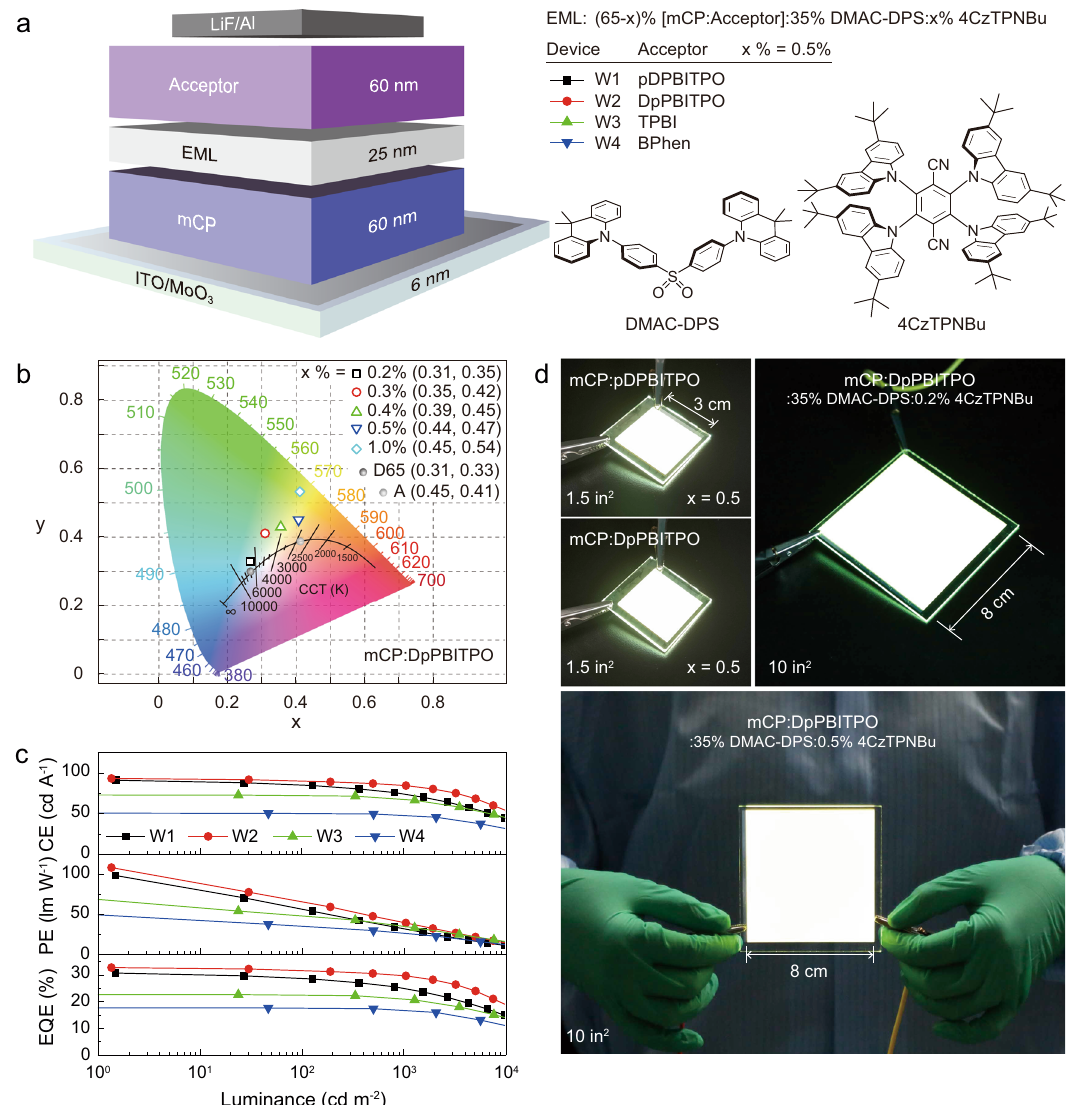
Fig. 4 Electroluminescence characterizations of single-emissive-layer TADF WOLEDs comprising ladder-like energy-relaying exciplexes. a An illustration showing device con fi guration, the emissive layer components of mCP:pDPBITPO- and mCP:DpPBITPO-hosted white TADF devices, and molecular structures of the doped dye emitters. b Commission International de I ’ Eclairage (CIE) coordinates of mCP:DpPBITPO-hosted TADF WOLEDs, fabricated with mCP:DpPBITPO:35% DMAC-DPS:x%4CzTPNBu. Their chromaticity is comparable to that of a standard daylight source (Illuminant D65) or an incandescent light (Illuminant A). c Ef fi ciency vs . luminance measurements of the devices based on 35% DMAC-DPS and 0.5% 4CzTPNBu codoped mCP:pDPBITPO (W1), mCP:DpPBITPO (W2), mCP:TPBI (W3) and mCP:BPhen (W4). d Photographs of mCP:pDPBITPO- and